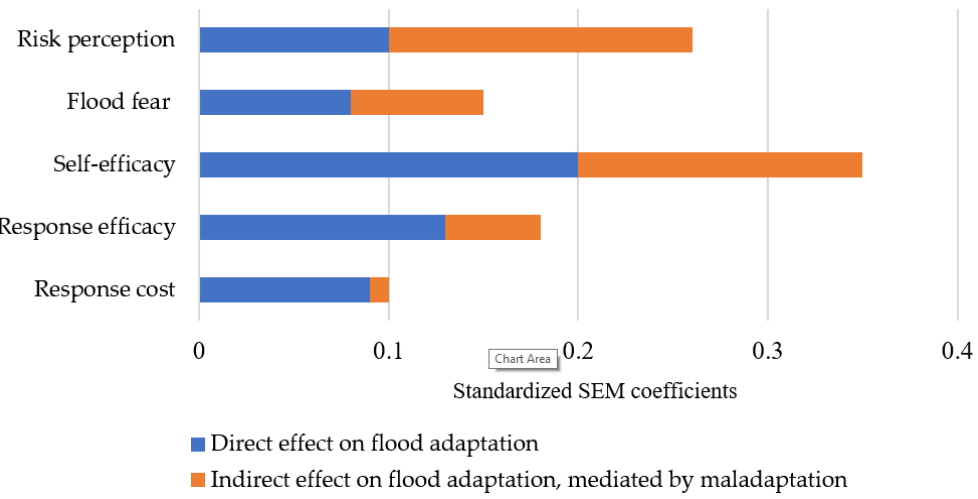
Figure 5. Total effects (SEM standardized coefficients) of the model’s predictor variables on the farmers’ flood adaptation.